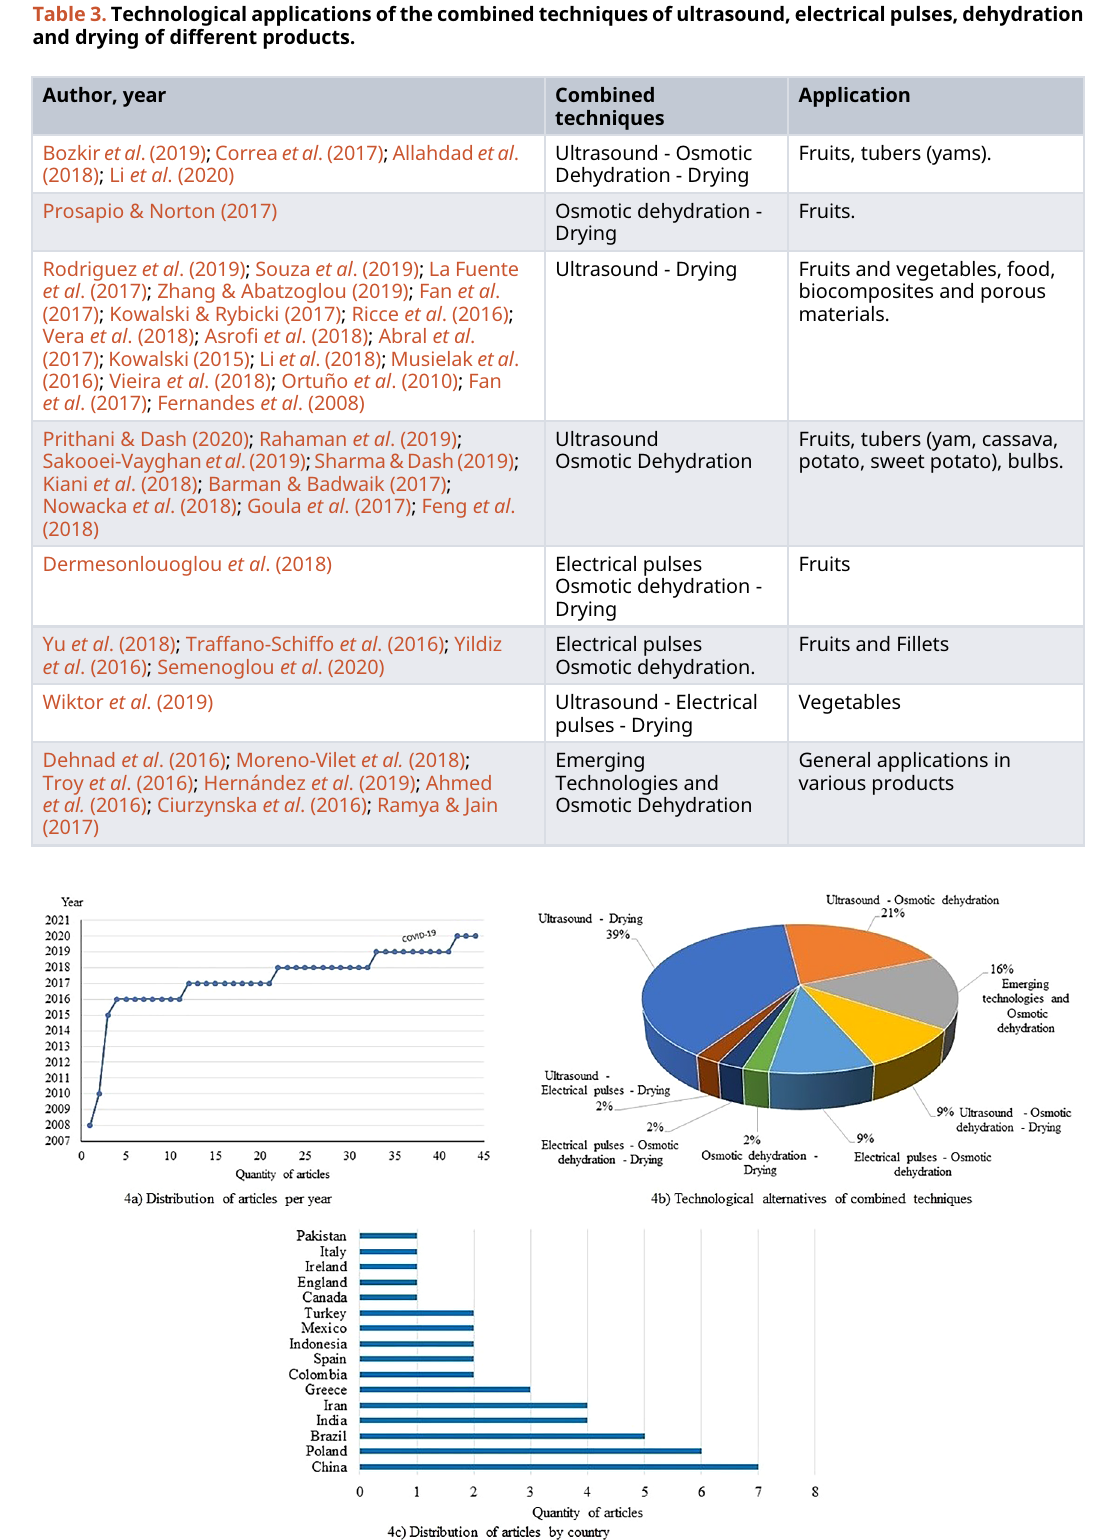
Figure 4. Statistics of studies on the applications of the combined techniques of ultrasound, electrical pulses, dehydration and drying of different products: a) Distribution of articles per year; b) Technological alterna- tives of combined techniques; c) Distribution of articles by